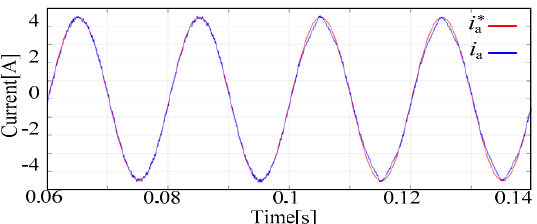
Figure 7. The amplification waveforms of reference current and actual current for phase A.